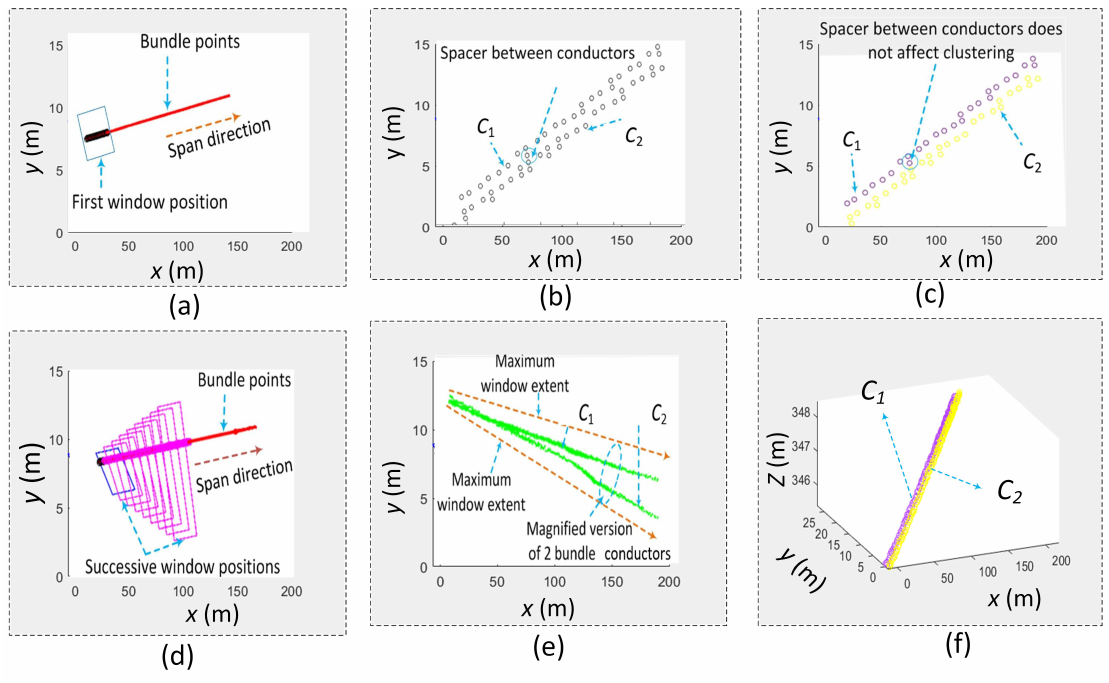
Figure 6. Complete subconductor extraction from a bundle: ( a ) initial window position; ( b ) points within the initial window; ( c ) two clustered conductors; ( d ) successive positions of the sliding window; ( e ) magnified version of part of the bundle; ( f ) final clustered conductors. In panels ( a – f ) the origin (0, 0) represents (4.0808 × 10 5 , 5.90348 × 10 6